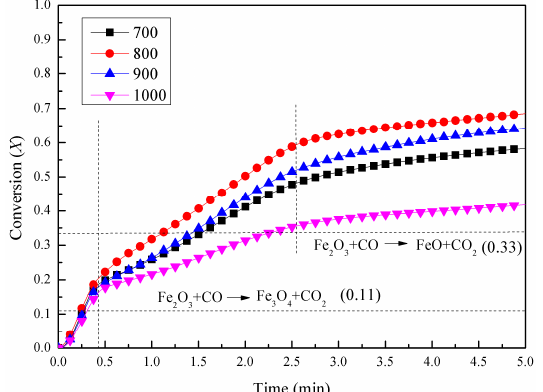
Figure 8. Conversion χ as a function of reaction time for the fifth reduction period at 700 °C, 800 °C, 900 °C, and 1000 °C.